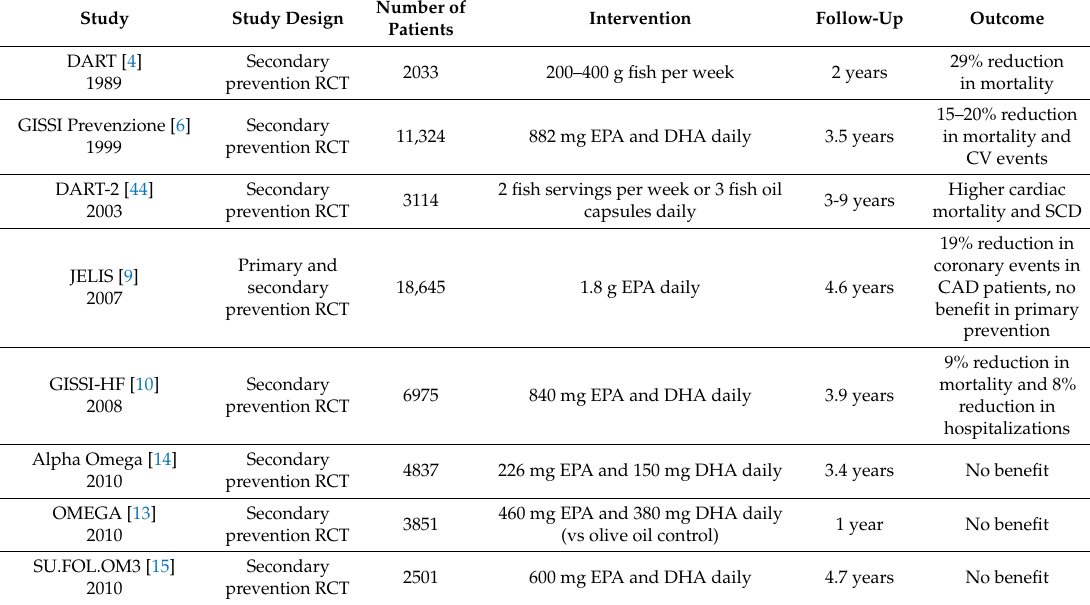
Table 2. Trials and meta-analyses of ω -3 PUFAs in cardiovascular disease